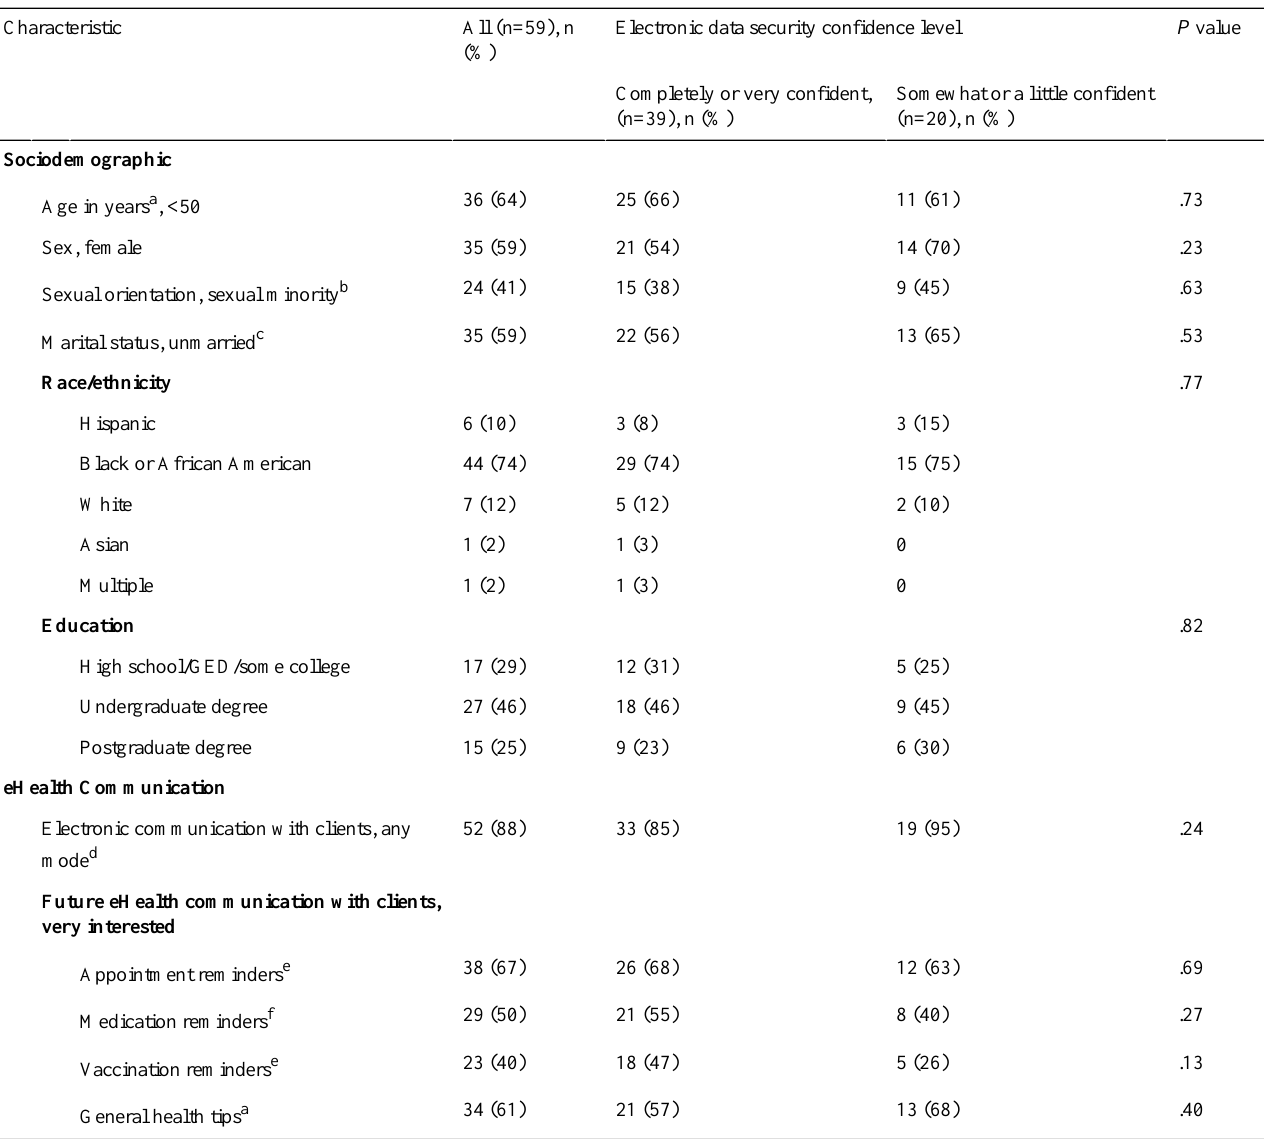
Table 2. Bivariate associations between sociodemographic characteristics and eHealth communication modes of staff at community-based HIV/AIDS service organizations by electronic data security confidence level